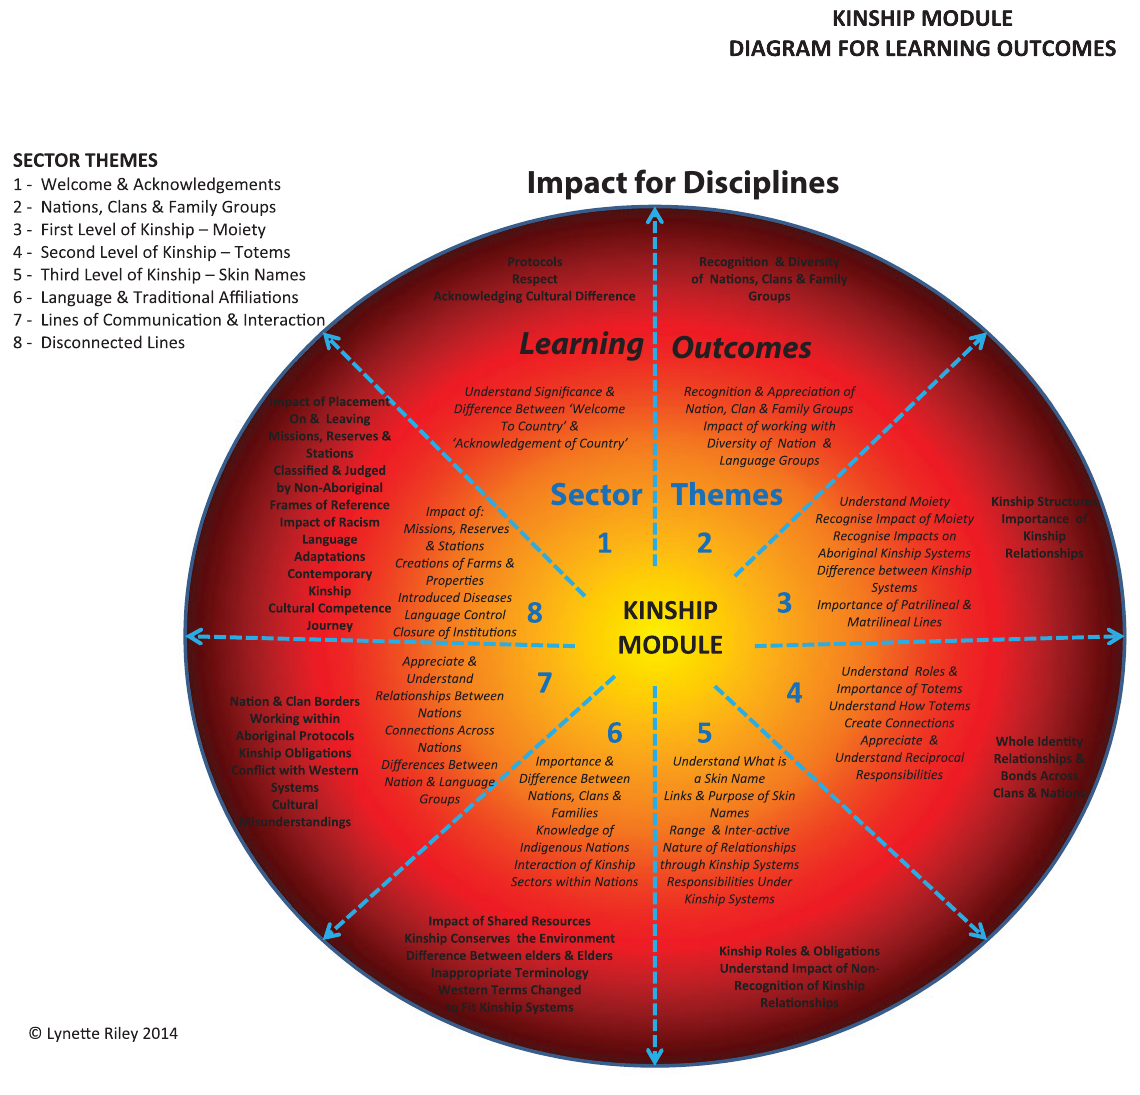
(Colour online) Kinship Module: Diagram For Learning Outcomes